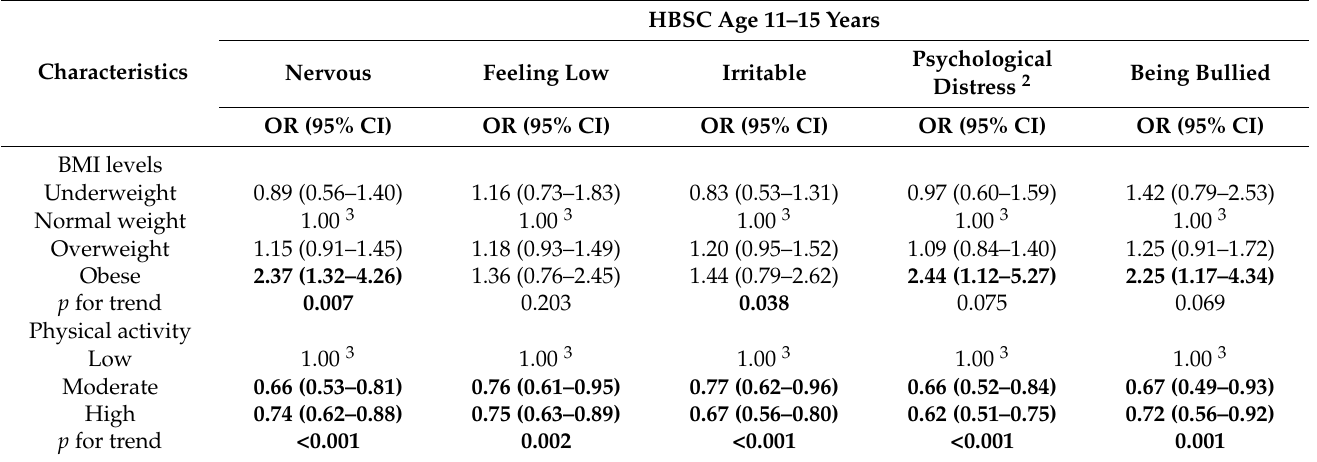
Table 4. Odds ratios 1 (OR) and corresponding 95% confidence intervals (CI) for selected mental health outcomes by body mass index (BMI) levels and physical activity. Lombardy,